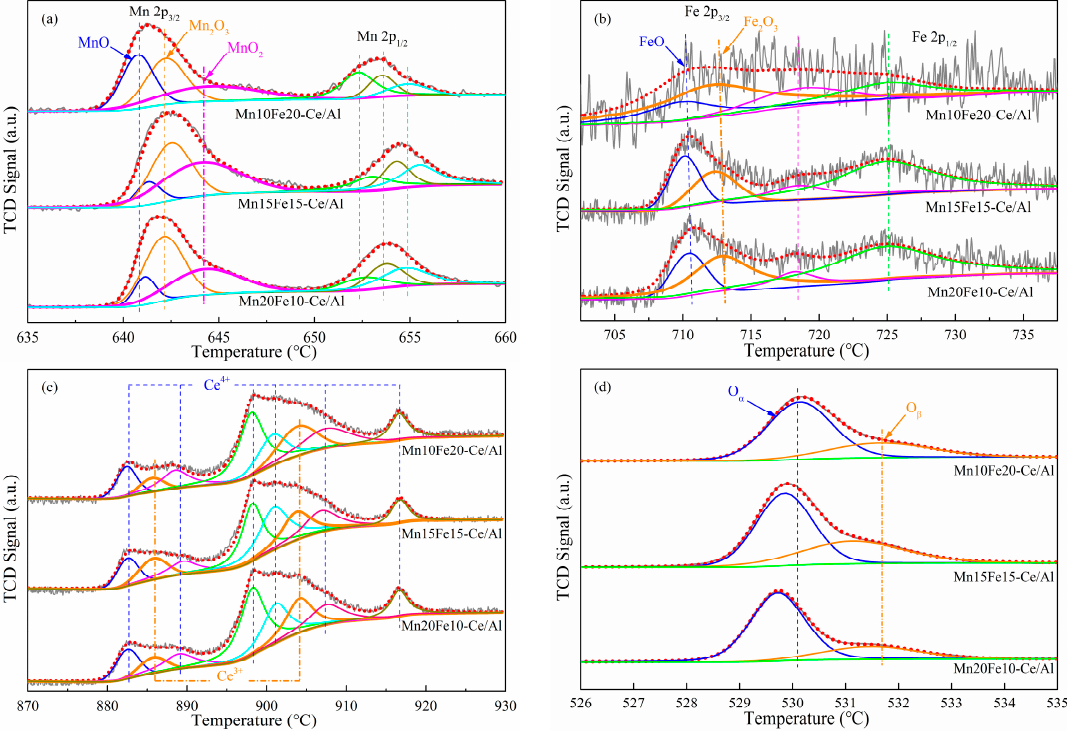
Figure 3. X ‐ ray photoelectron spectroscopy (XPS) analysis of Mn − Fe − Ce − O x / γ‐ Al 2 O 3 nanocatalysts: ( a ) XPS spectra for Mn 2 p ; ( b ) XPS spectra for Fe 2 p ; ( c ) XPS spectra for Ce 3 d ; ( d ) XPS spectra for O 1 s .